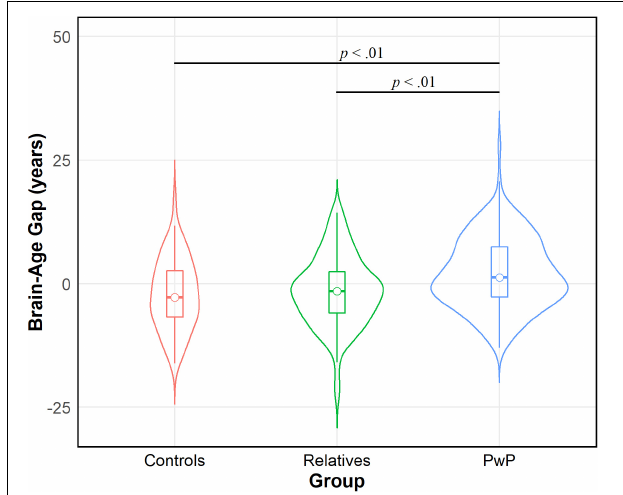
FIGURE 1 | Violin density plot of group comparison on brain-age gap. People with psychotic disorders (PwP) demonstrated a greater estimated brain-age